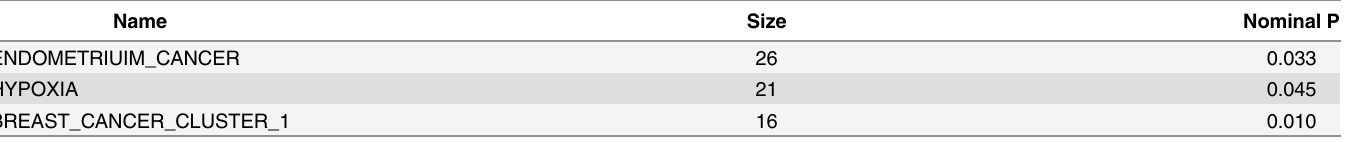
Table 2. The list of 3 up-regulated gene sets in the endometrium of patients with RIF.